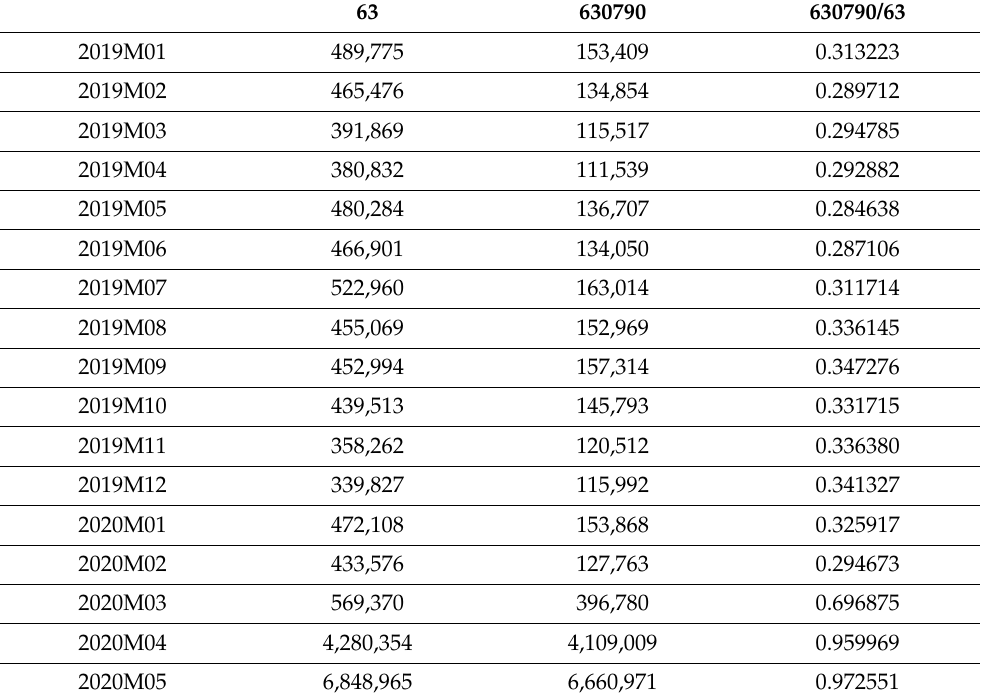
Table A3. Proportion of specification 630790 in product